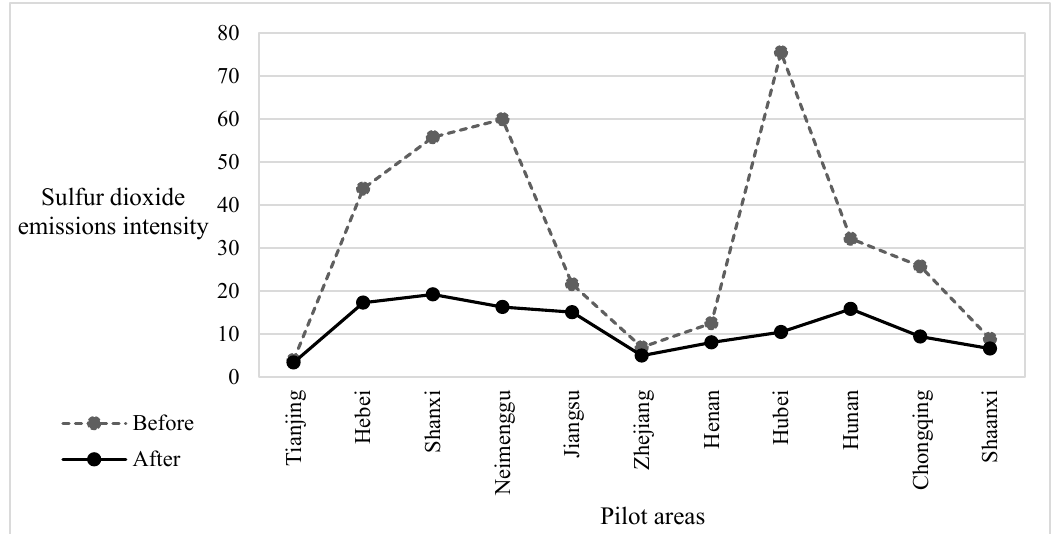
Figure 4. Comparison of emission intensity before and after the pilot